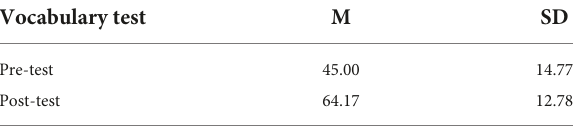
TABLE 1 Mean and standard deviation of the students’ pre-test and post-test of vocabulary test.